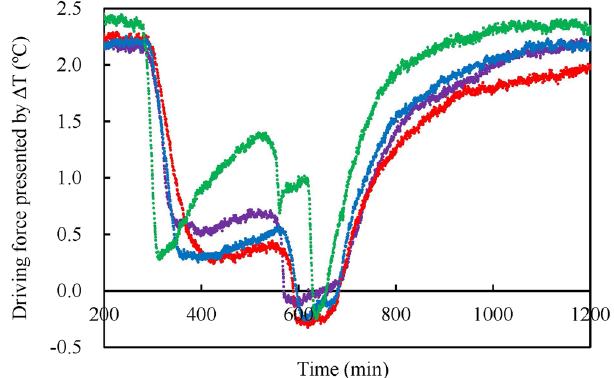
Figure 8. Driving force indicated by the sub-cooling temperature, which was calculated as the difference between the theoretical equilibrium temperature of 4.31 °C at 4.0 MPa and the temperature measured during the experiments shown in Fig.